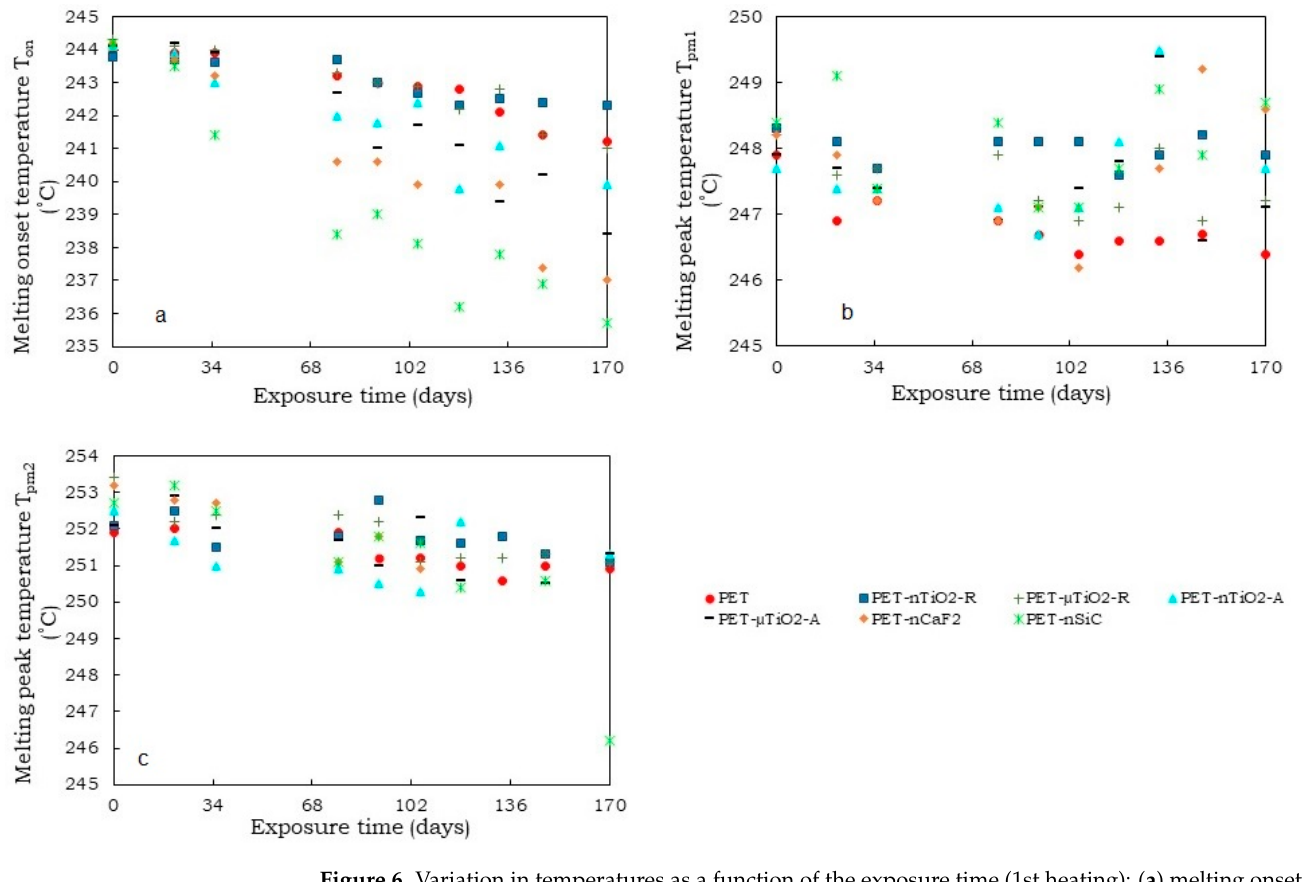
Figure 8. Thermograms of the second heating of the polymer blends after 170 days of exposure. As for the melting onset temperature T on (Figure 9a), a slight increase was observed with respect to the value for pure PET. Nevertheless, the standard deviation was ± 0.4 °C, which was within the experimental error of the test. For TiO 2 -containing polymer blends, no clear trend was observed during the exposure time; however, there was a tendency for this value to increase. For the PET-nCaF 2 and PET-nSiC blends, the changes were more